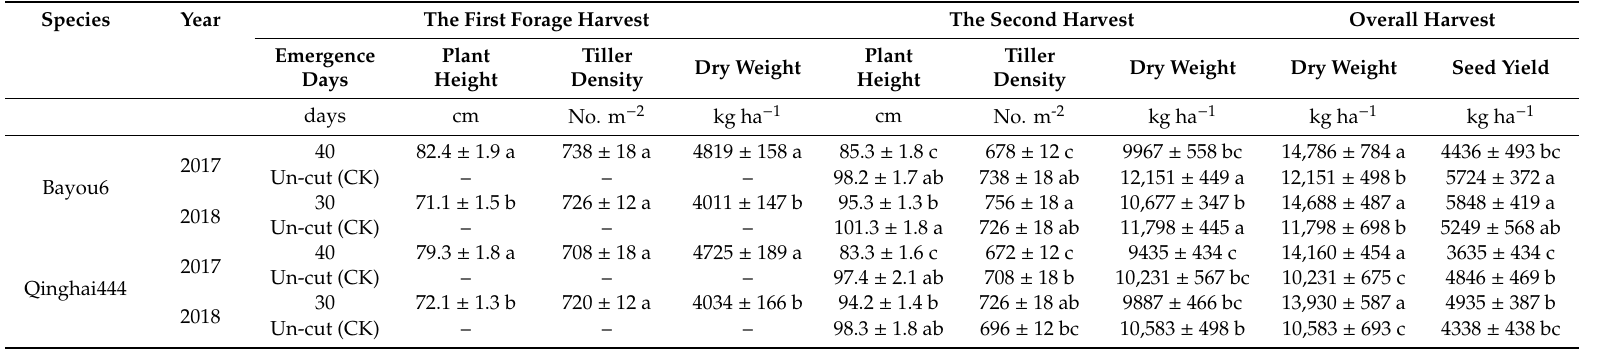
Note: Data are means ± SE ( n = 4). “–” indicates no harvesting. Di ff erent lowercase letters indicate significant di ff erences in each